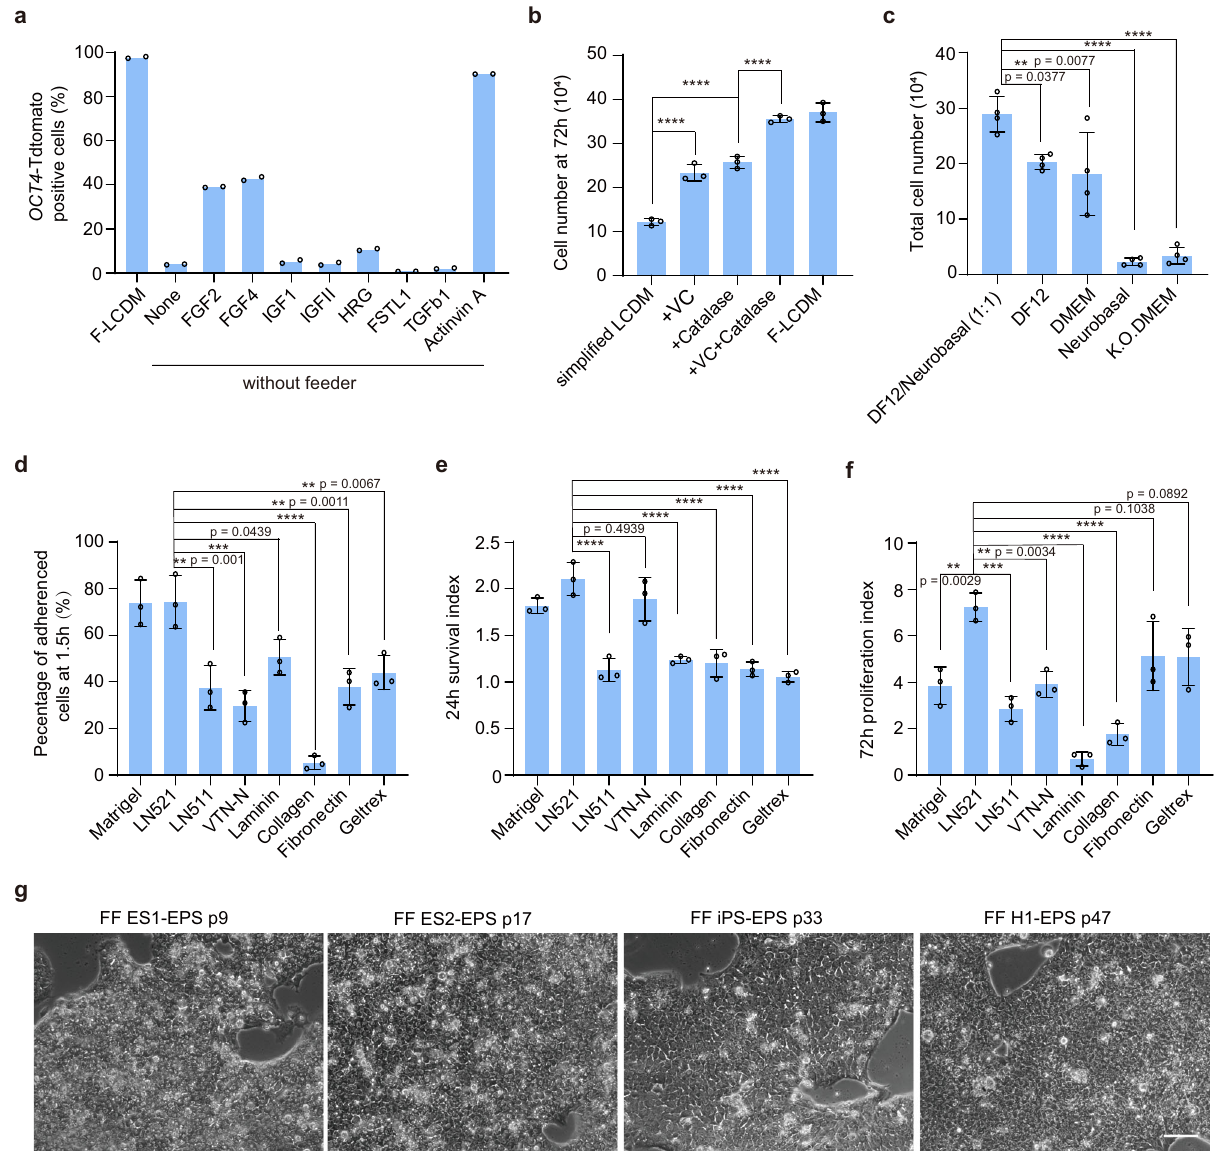
Fig. 1 Development of a xeno-free culturing condition for human EPS cells. a FACS analysis of the percentages of OCT4-Tdtomato + H1-EPS cells with indicated factor treatment after 2 passages. n = 2 biologically independent samples. None, LCDM medium. b Analysis of cell numbers of feeder-free cultured hEPS cells under the treatments of vitamin C, catalase, and their combination. VC, vitamin C. n = 3 biologically independent samples. ES1-EPS cells were used. c Analysis of cell numbers of feeder-free cultured hEPS cells in different basal culturing media. n = 4 biologically independent samples. ES1-EPS cells were used. d – f Analysis of the effects of different matrix proteins on feeder-free cultured hEPS cells. The percentages of adherent hEPS cells at 1.5 h after seeding was shown in d . Survival of dissociated hEPS cells 24 h after seeding was shown in e . Proliferation of hEPS cells at 72 h after seeding was shown in f . For e , f , index represents the cell number at a speci fi c time point divided by the number of seeding cells. For d – f , n = 3 biologically independent samples. ES1-EPS cells were used. g Representative morphologies of xeno-free hEPS cells with different genetic backgrounds. Similar images were obtained in at least 5 independent experiments. Error bars, mean ± SD. All differences between means with P < 0.01 are indicated. ** P < 0.01; *** P < 0.001; **** P < 0.0001. Statistical signi fi cance was analyzed using one-way ANOVA with Tukey multiple comparison test in b – f . Scale bar, 100 μ m. Experiments in a – g were all independently repeated at least three times with similar